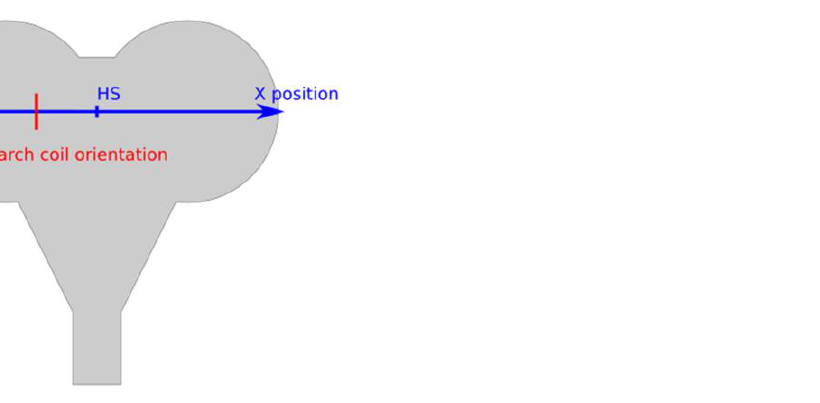
Figure 2. Schematic diagram of magnetic flux change measurement. The blue line indicates the position at the time of measurement, where the hot spot (HS) is 0, the right side shows positive and the left side shows negative. The red line shows the orientation of the search coil with respect to the coil to be measured.